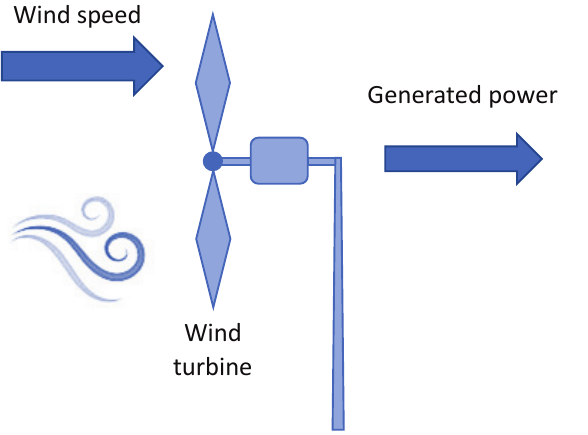
Figure 4. Computation of wind generation potential, based on the wind speed forecasting.